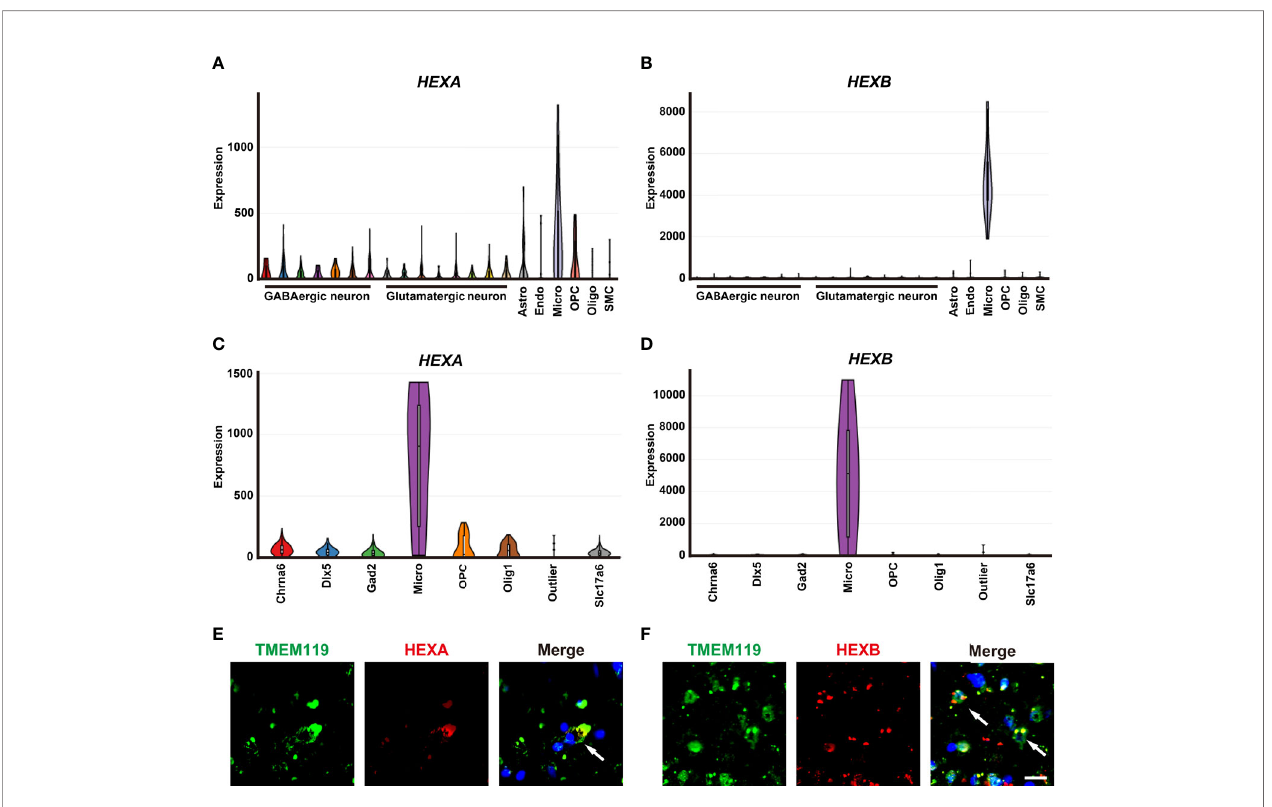
FIGURE 3 | Upregulation of HEXA andHEXBin microglia of GBMpatient samples. (A, B) Tasic ’ s scRNA-seq showed that mRNA levelsof HEXA and HEXB in microglia were higher than those inother celltypes inthe nervous system. (C,D) The Allen Institute for Brain Science RNA-seq transcriptomic pro fi ling showed that mRNA levelsof HEXA and HEXB in microgliawere higher than those inother celltypes in the nervous system. (E,F) Doubleimmunostaining ofHEXA/HEXB(red) andTMEM119 (green)in GBMpatient samples. Astro(Astrocytes),Endo(Endothelial cells),Micro (Microglia), OPC (Oligodendrocyte precursor cells), Oligo (Oligodendrocyte),SMC (Smooth muscle cells), Chrna6 (Cholinergicneuron), Dlx5 (Neural stem cell), Gad2 (GABAergicneurons),Slc17a6(Glutamatergicneurons).Scalebars = 20 m